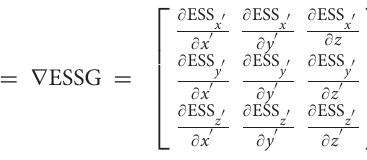
all results presented are only from the final cycle. CFD